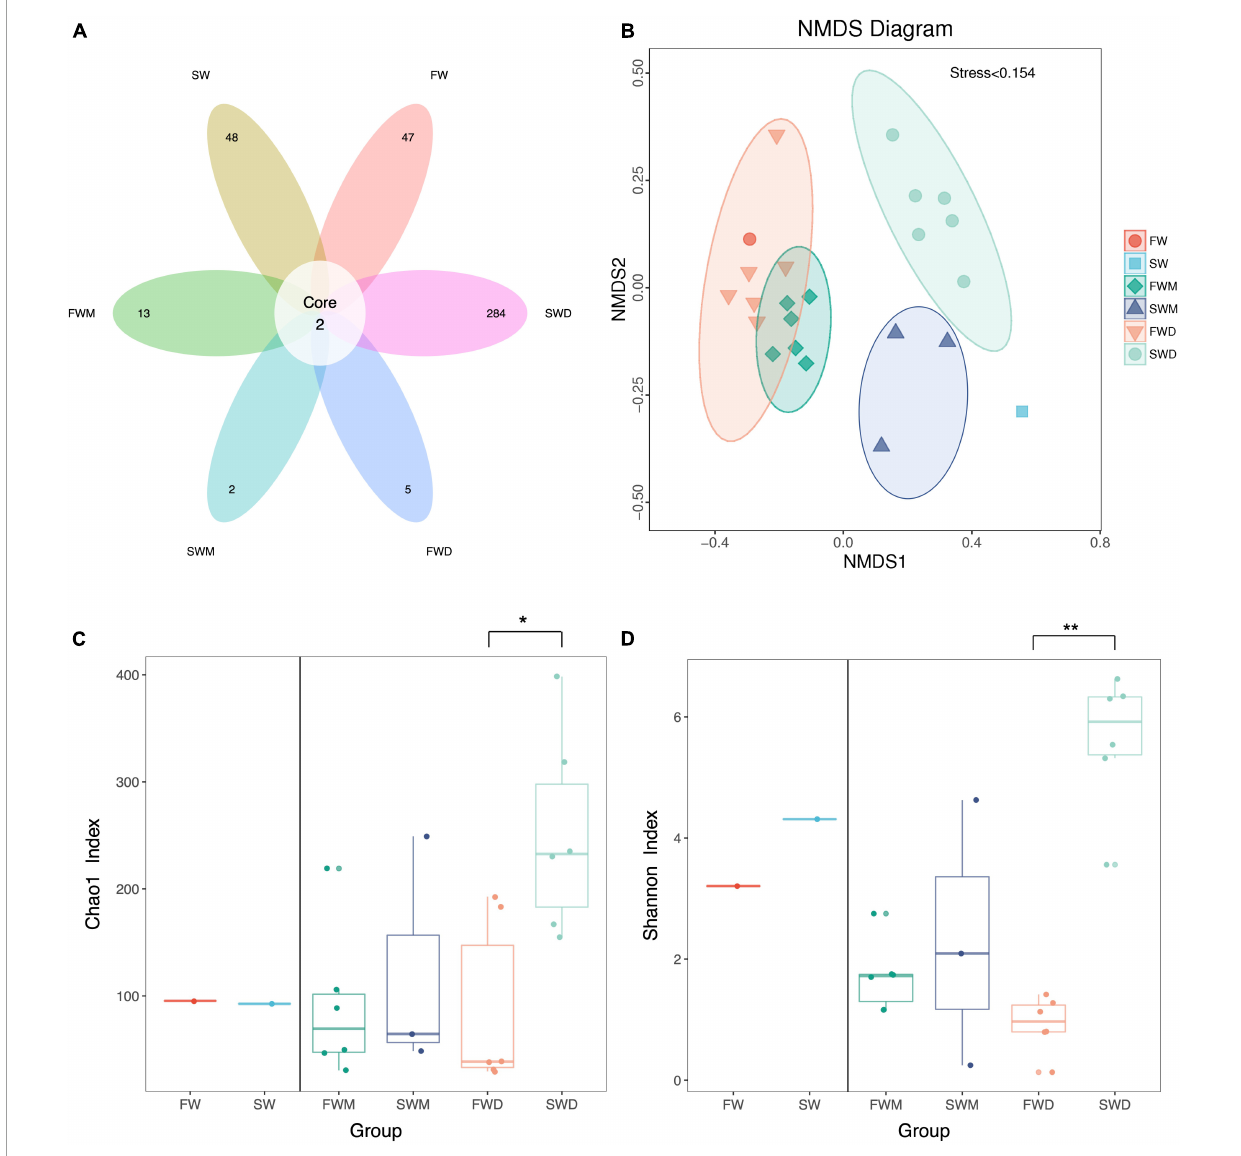
FIGURE1 Alpha and beta diversity of gut microbiota of Asian sea bass. (A) The Venn diagram revealed core and unique operation taxonomic units (OTUs) among different groups. (B) The NMDS plot revealed beta diversity between different groups. (C) Chao 1 and (D) Shannon index revealed alpha diversity. SW, seawater; FW, freshwater; FWM, freshwater mucosa samples; SWM, seawater mucosa samples; FWD, freshwater digesta samples; SWD, seawater digesta